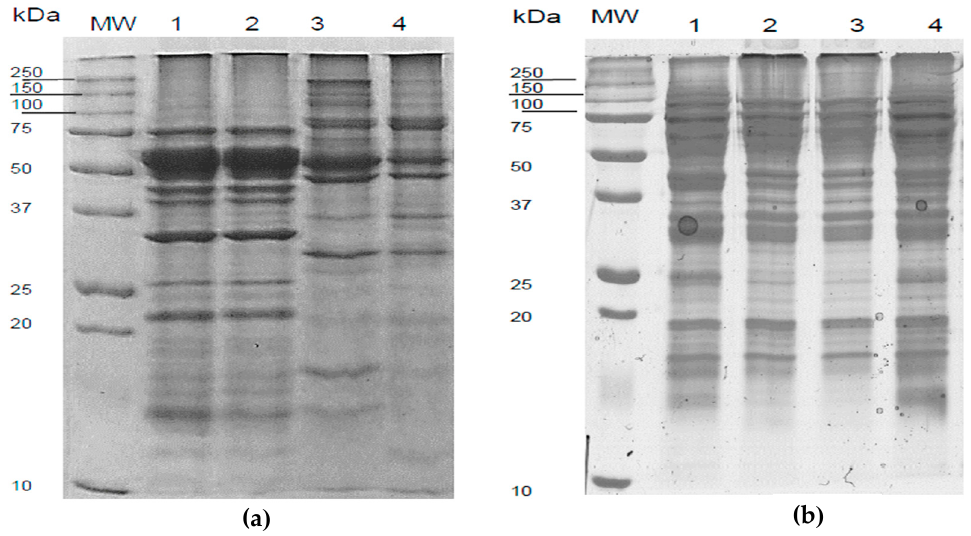
Figure 9. Electrophoretic profile for ( a ) L. mutabilis and ( b ) L. angustifolius protein extracts in non- reducing conditions. Line 1 is defatted flour; Line 2 is protein isolate; Line 3 protein isolate using 10 min US-assisted extraction and Line 4 protein isolate using a 15 min US-assisted extraction. MW-Molecular weight standard.